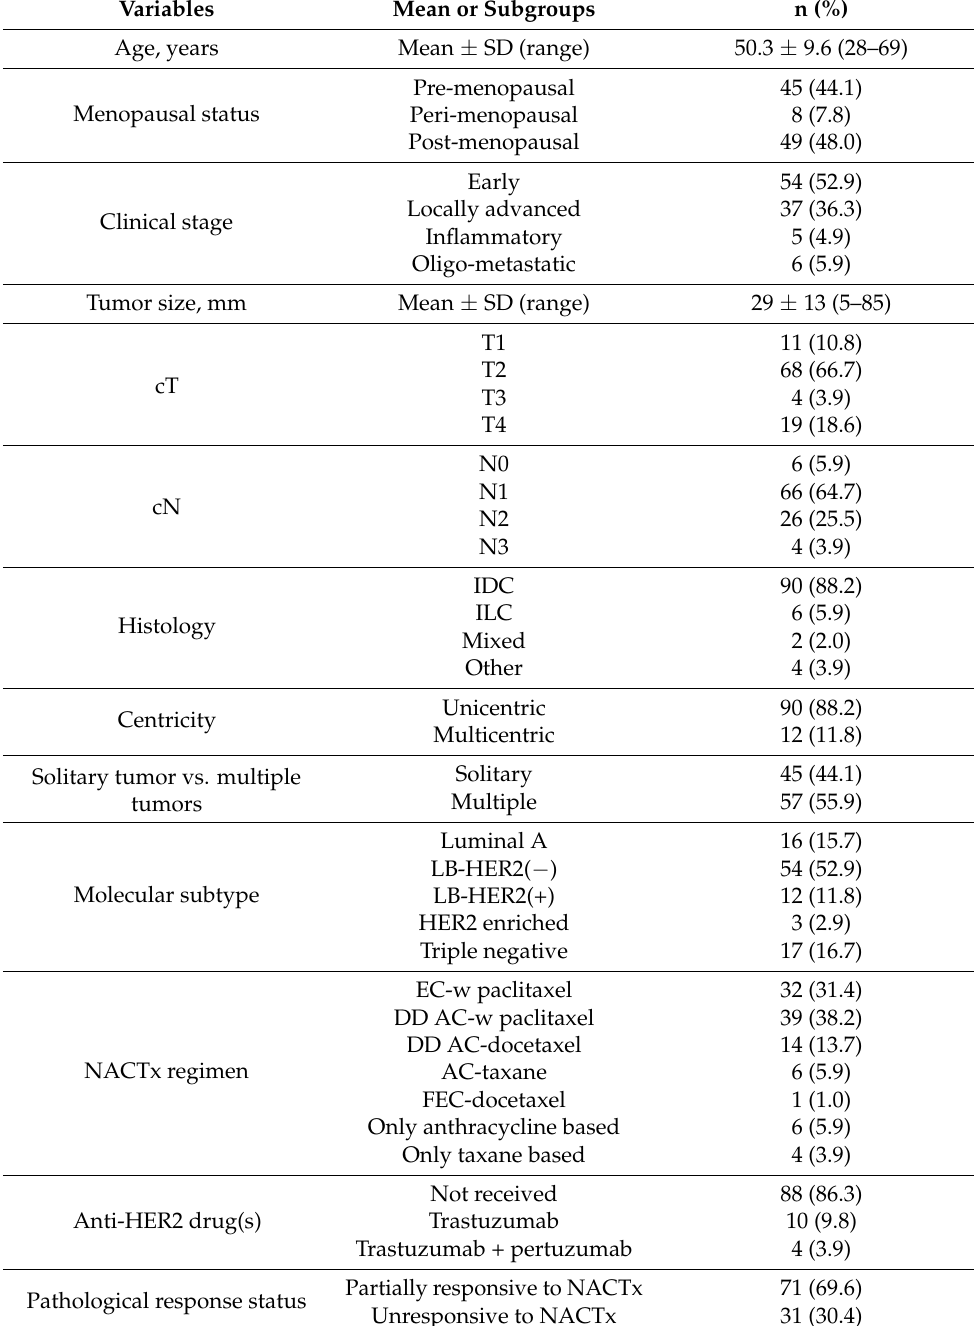
Table 1. Clinicopathological features, NACTx regimens, and pathological outcomes of the